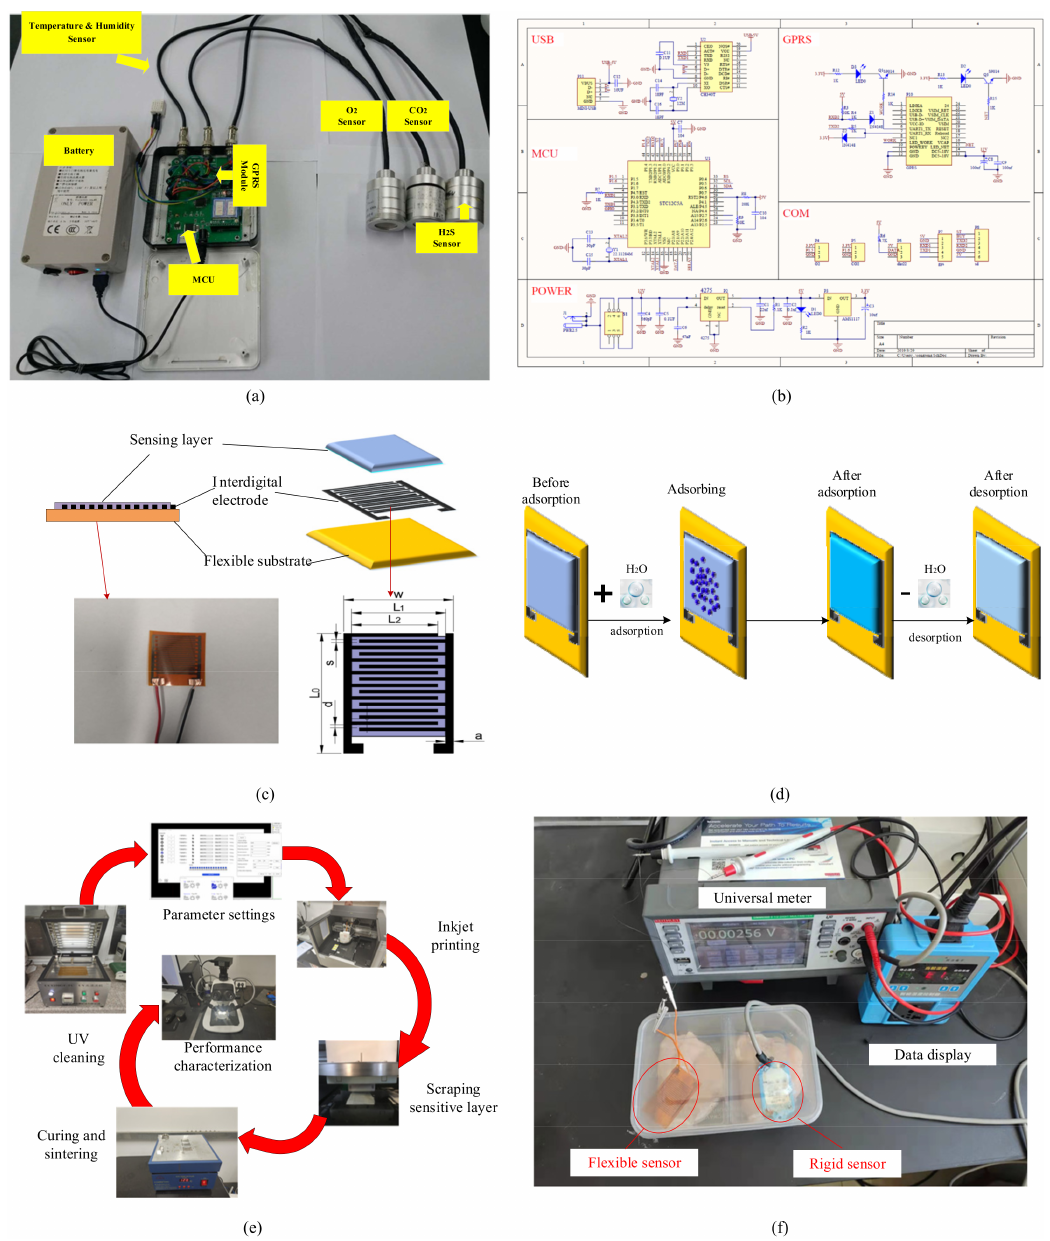
Figure 2. The monitoring equipment architecture. ( a ) The hardware architecture; ( b ) Multi-parameter information collection circuit diagram; ( c ) Flexible humidity sensor block diagram; ( d ) Flexible humidity sensing mechanism; ( e ) Flexible sensor fabrication process; ( f ) Comparison experiment between flexible humidity sensor and conventional